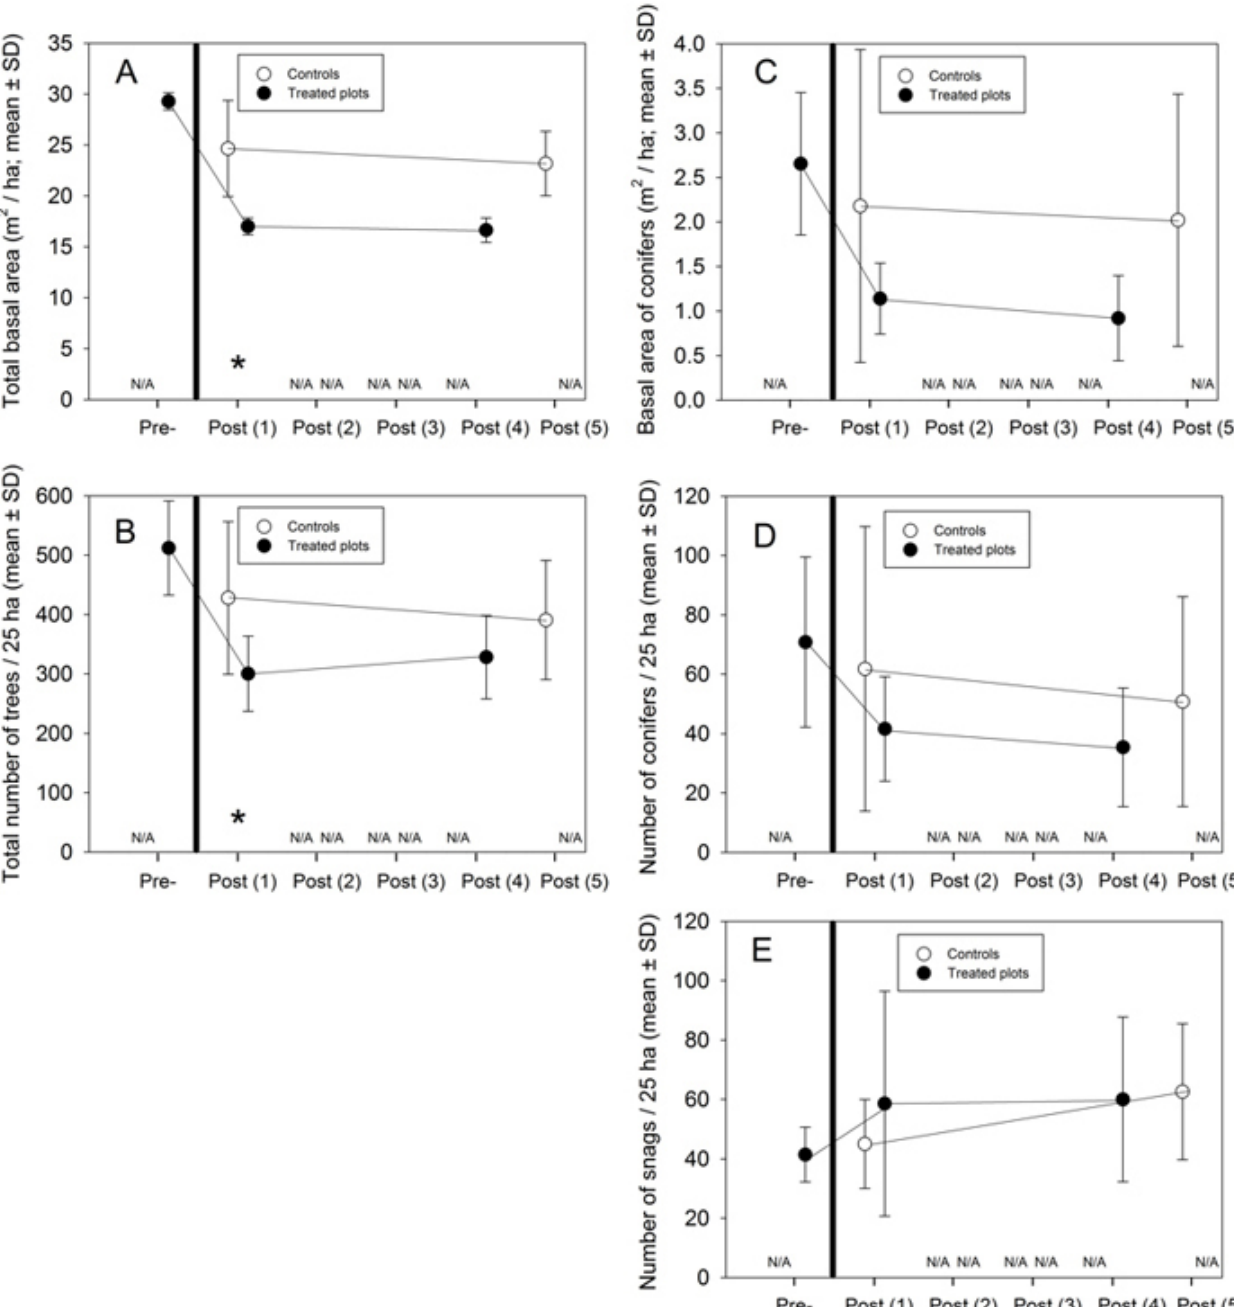
Fig. 1 . Mean (± SD) total basal area (A), density of live trees (B), basal area (C), and density of live conifers (D), and density of snags (E) in plots treated by selection harvesting and controls during the preharvest year, first year postharvest, and the fourth year postharvest. The solid line delineates the pre- from the postharvest and asterisks (*) indicate significant year- specific treatment